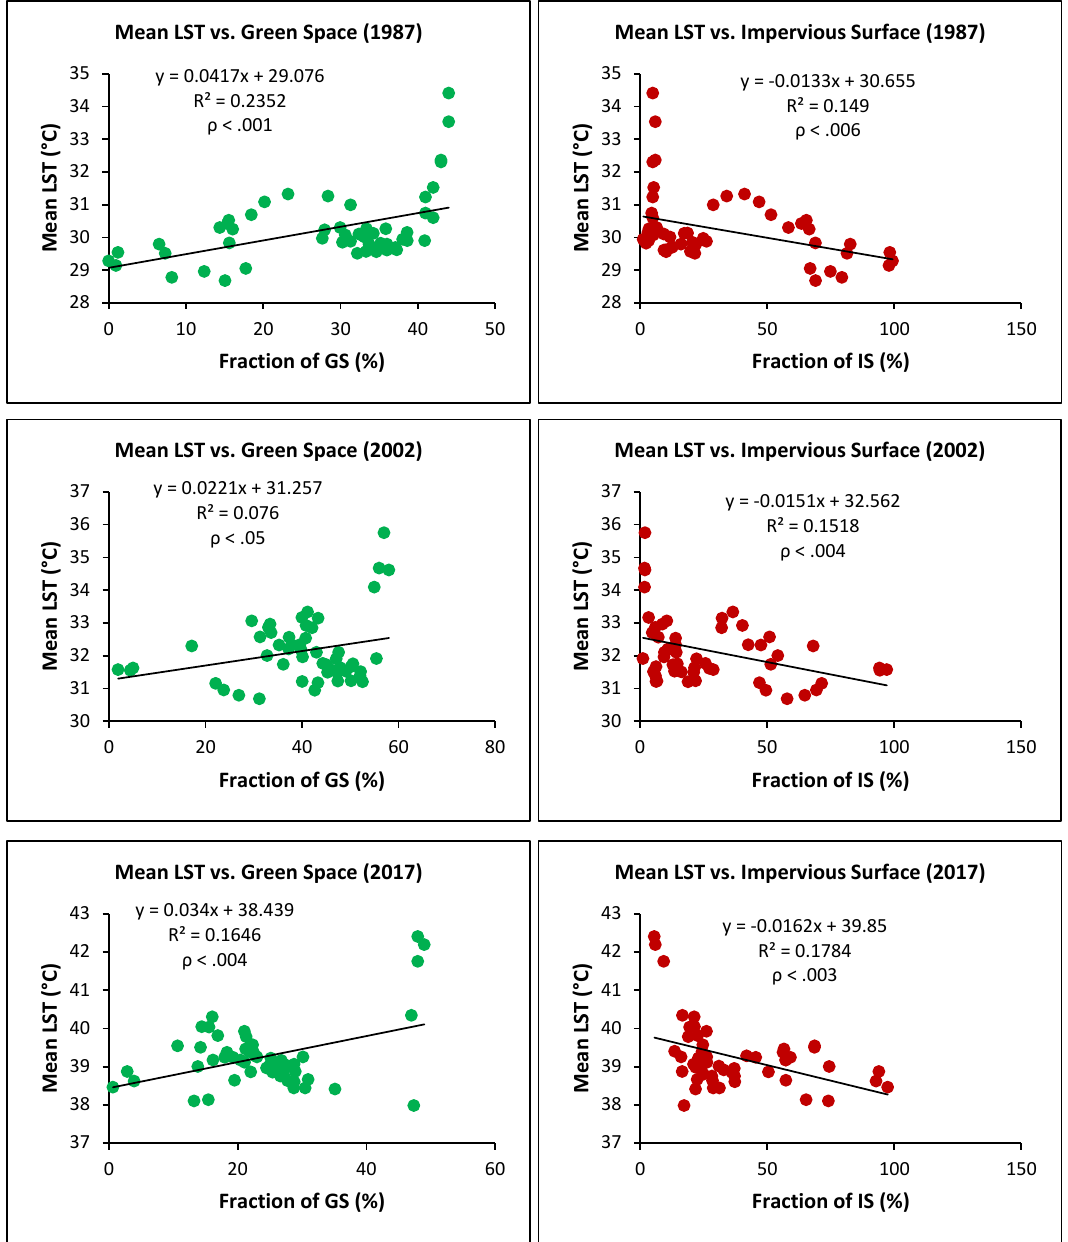
Figure 7. Scatter plots and statistical relationships (GS and IS).